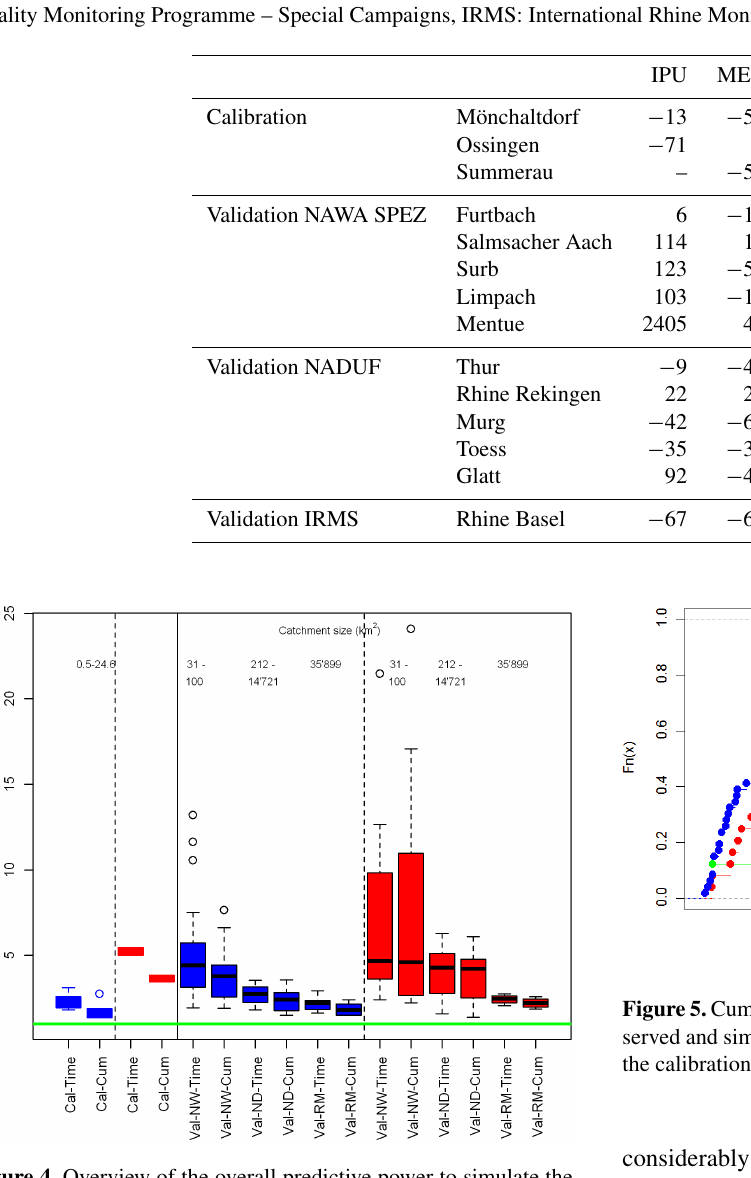
Figure 4. Overview of the overall predictive power to simulate the concentrations levels during the calibration and validation phase as quantified by the geometric reliability index (GRI). A value of 1 (green horizontal line) indicates a perfect match; the larger the